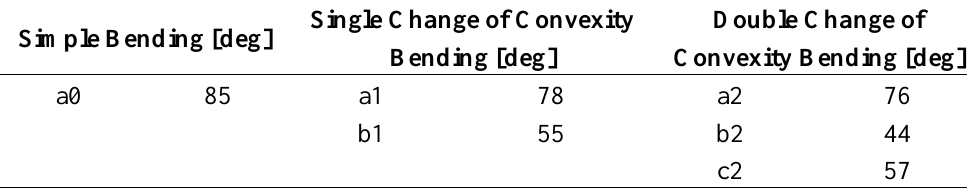
Table 1. Operating limit angles in different activation